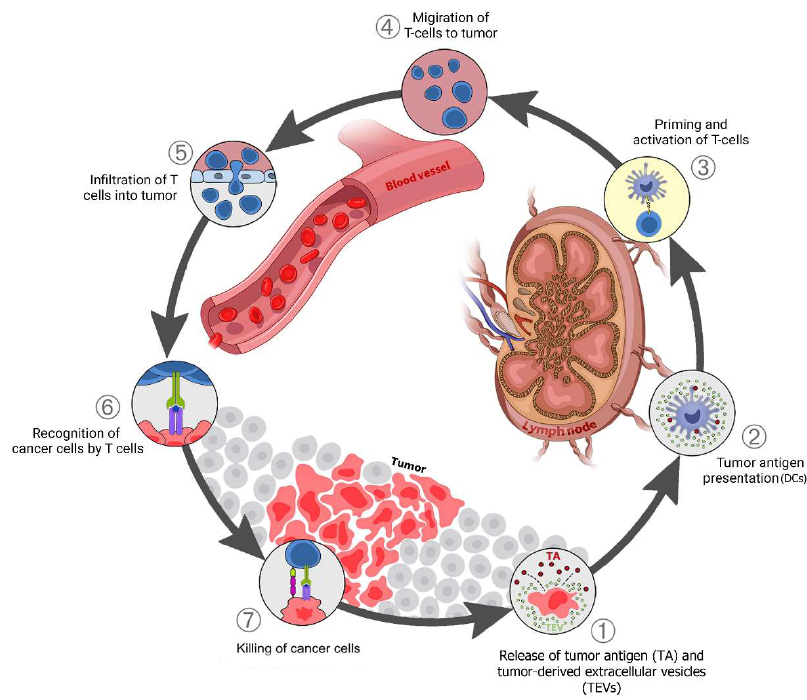
Figure 2. TEV in the cancer-immunity cycle: ( 1 ) Release of tumor antigens (TAs) along with tumor- derived extracellular vesicles (TEVs) that carry TA + DAMPs from dying cancer cells; ( 2 ) Presentation of TAs on the major histocompatibility complex (MHC) by dendritic cells; ( 3 ) T-cell receptor recognition of TAs on the MHC, leading to T-cell activation; ( 4 ) Migration of activated T cells to the tumors; ( 5 ) T-cell infiltration into the tumor; ( 6 ) Recognition of cancer antigens within the tumor; ( 7 ) Attack and killing of tumor cells.